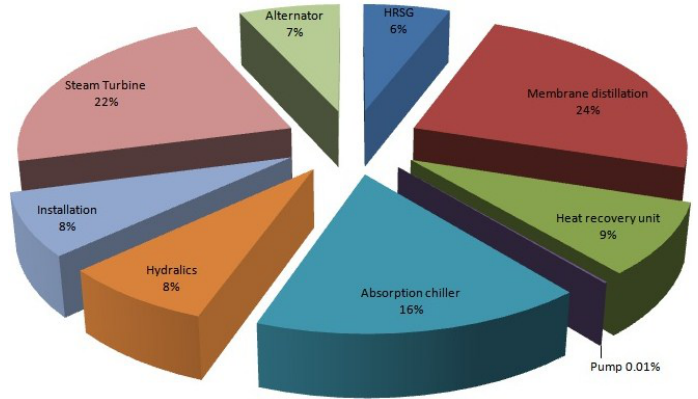
Figure 17. Distribution of investment cost.